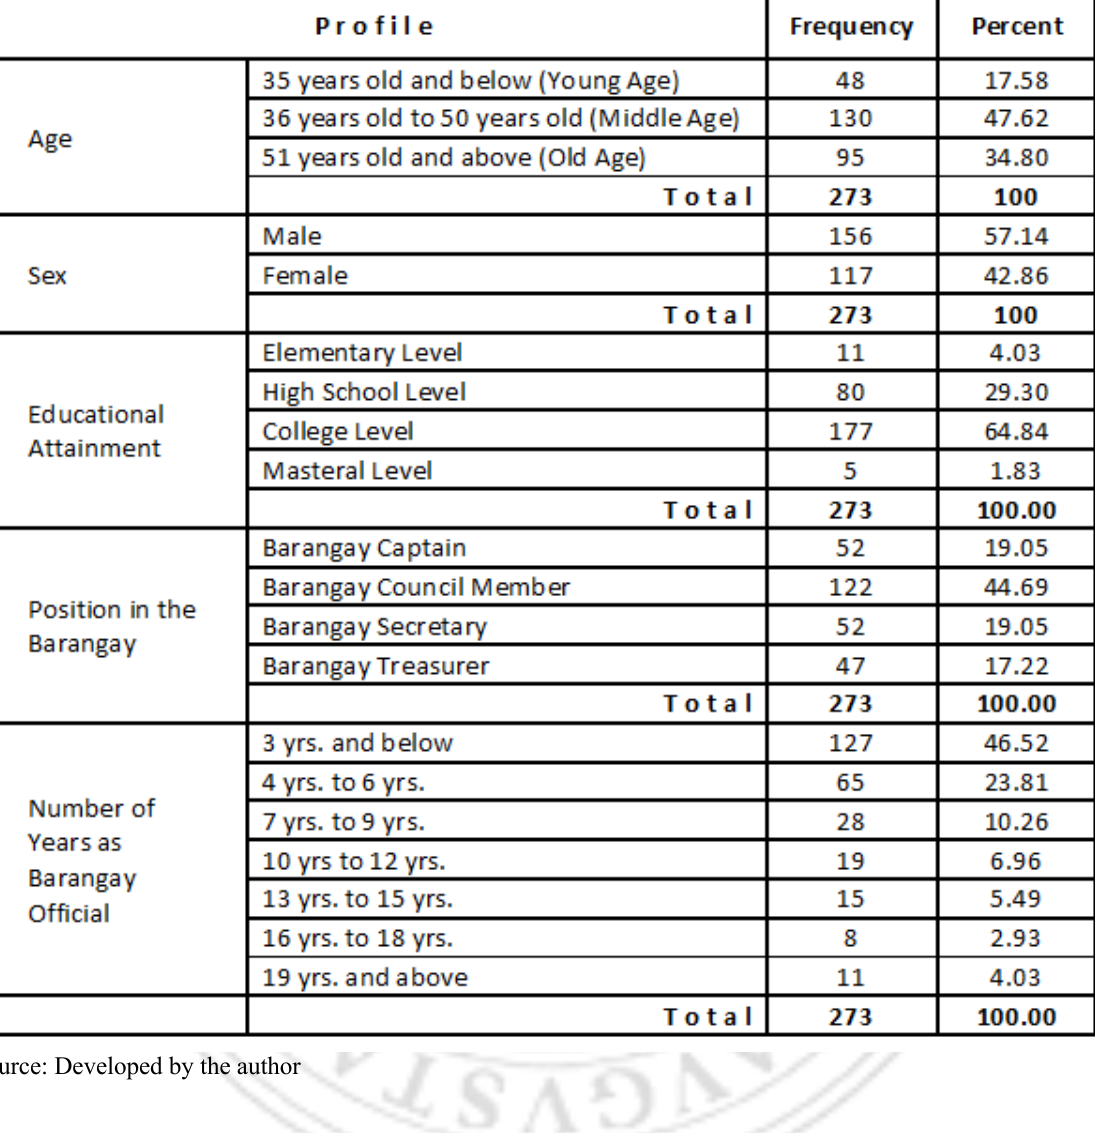
Table 2: Profile of the Respondent-Barangay Officials in Northeast of